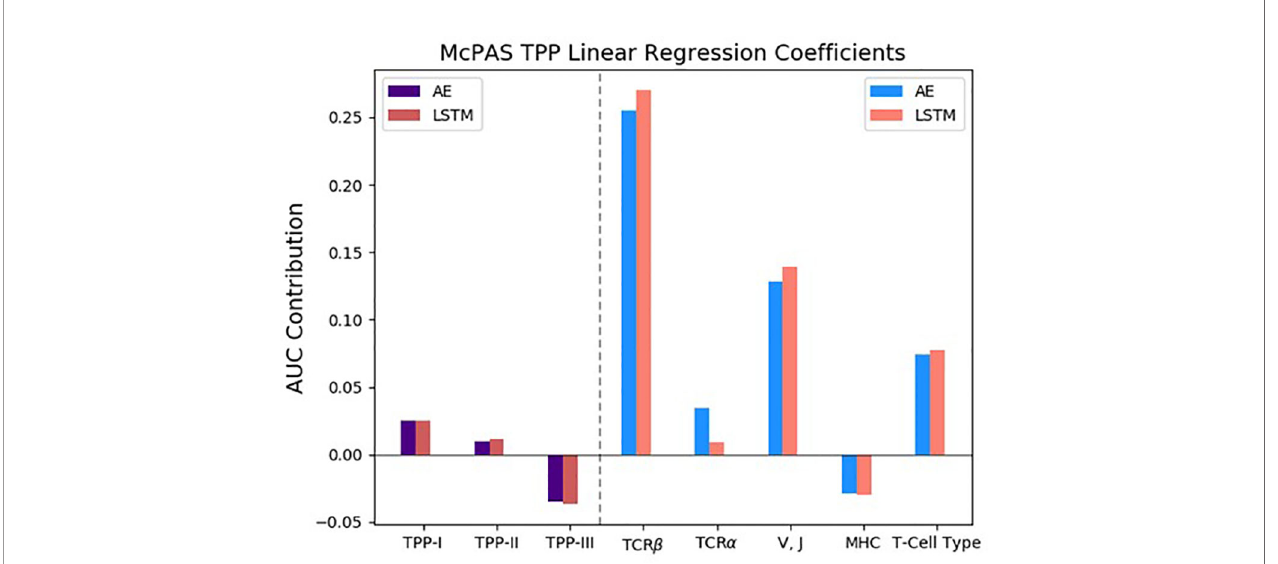
FIGURE 3 | The inferred linear regression coef fi cients of the TCR Peptide Pairing (TPP) results on the McPAS (20) database, matching the Area Under Curve (AUC) contribution. The included variables in the linear regression were the different types of the TPP evaluations, as well as the various features of ERGO-II. All variables were represented as one-hot vectors according to their usage in the different experiments (see Methods and Table 1 ). The left part of the graph shows that the more complex the TPP task, the lower the AUC contribution. Results are reported for AE-based and LSTM-based models. The different models perform similarly and the standard deviation between the models ’ inferred coef fi cients is bounded by